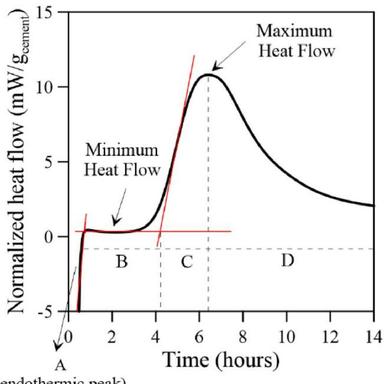
Different phases of cement hydration obtained from an isothermal calorimetric curve. (A) the initial or pre-induction period, (B) induction period, (C) accelerating period, and (D) decelerating period.